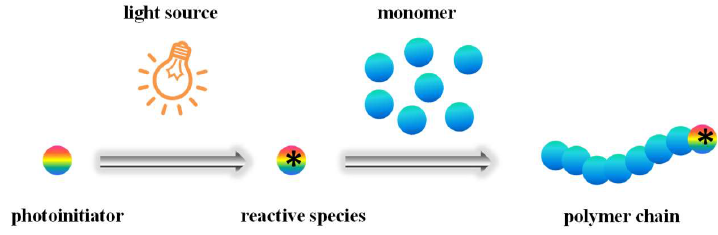
Figure 1. Schematic representation of photo-induced polymerization.